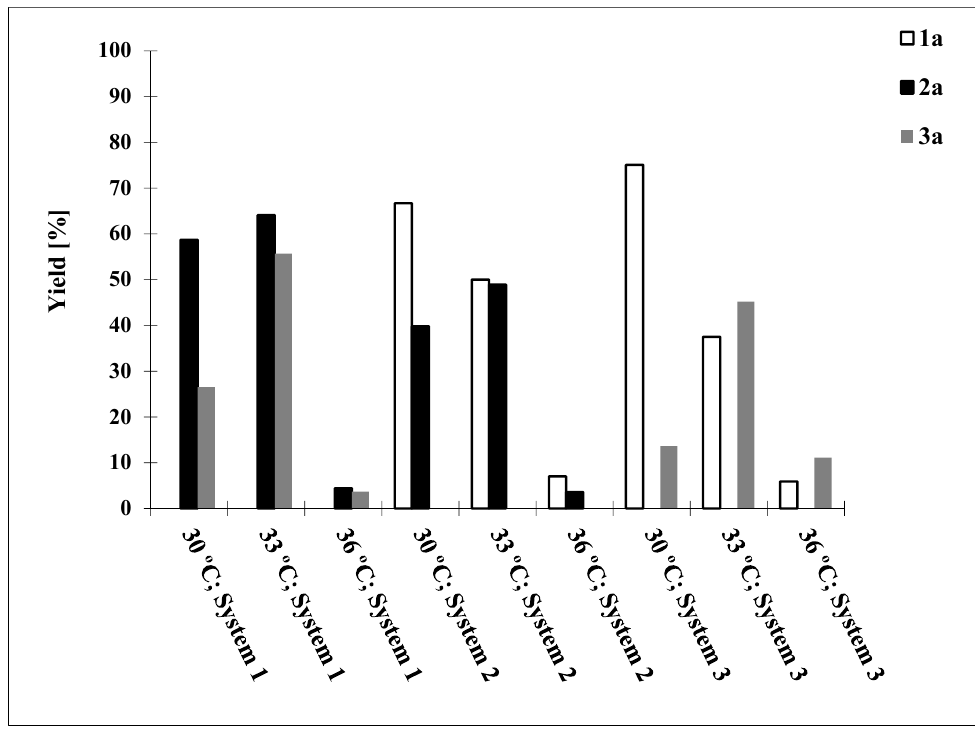
Figure 4. Comparison of 1 a– 3 a performance at 30 ° C, 33 ° C, and 36 ° C in different conditions. System 1: Phosphate buffer pH = 7.0, glucose, System 2: Phosphate buffer pH = 6.5, glucose, System 3: Phosphate buffer pH = 7.0, sucrose. Yields were determined by HPLC.